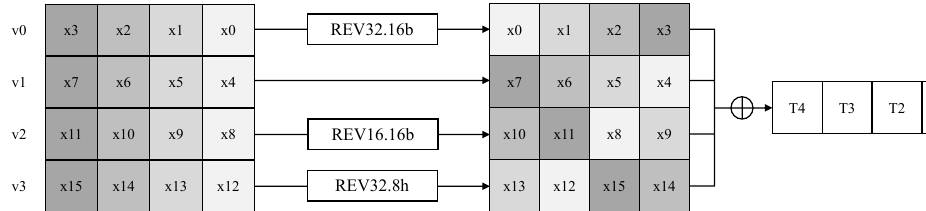
Figure 5. Simplified operation of the variable T . 16-PT Parallel Implementation on